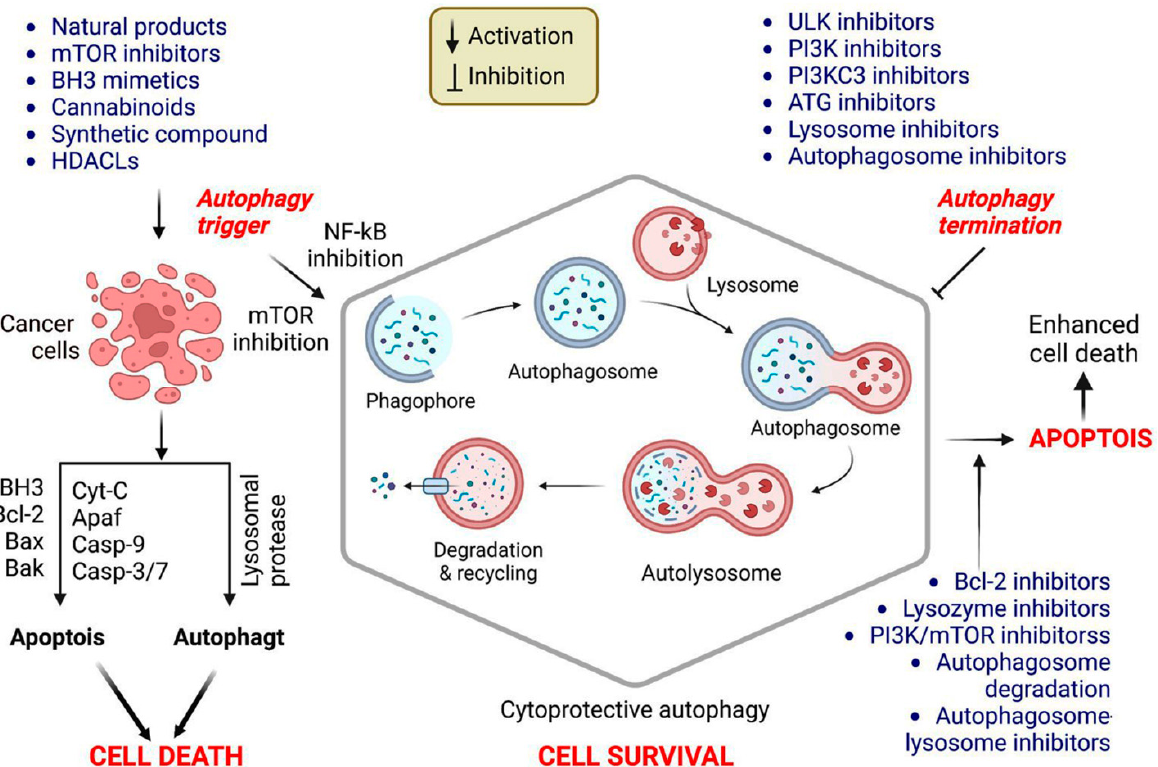
Figure 2. Mechanism of autophagy promotion and repression in cancer therapy. Apoptosis requires enhanced outer mitochondrial membrane permeability, which is mediated by the B-cell lymphoma 2 (Bcl-2) family (e.g., multidomain pro-apoptotic members Bak and Bax), culminating in the translocation of cytochrome (Cyt) C into the cytoplasm. Then, Cyt C binds to Apaf-1, activating the caspase pathways and inducing apoptosis. Bcl-2 family members predominantly regulate mitochondrial membrane permeability during apoptosis. When apoptosis is inhibited, various apoptotic triggers induce autophagy, culminating in active cell death (ACD). Cancer cells treated only with autophagy enhancers undergo apoptosis or autophagy or will activate cytoprotective autophagy, resulting in treatment resistance. Combining autophagy inducers and inhibitors enhances the cytotoxicity in cancer cells via cytoprotective autophagy inhibition. Further studies should be conducted to determine the function of autophagy triggered by cancer therapy, to design advantageous coadministration systems for drug delivery, and to uncover novel and effective autophagy suppressors.